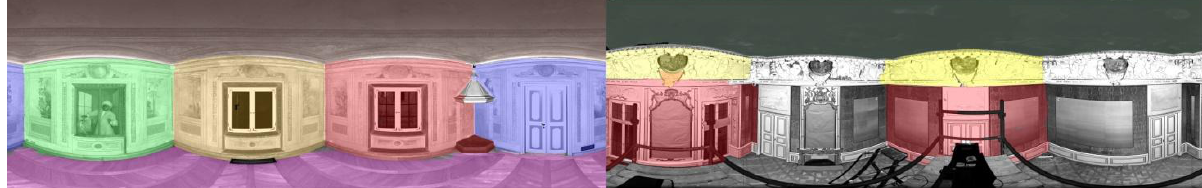
Figure 1: Point clouds of the test sites 1a and 2b in spherical projection, with fragments of the utilized orthoimages